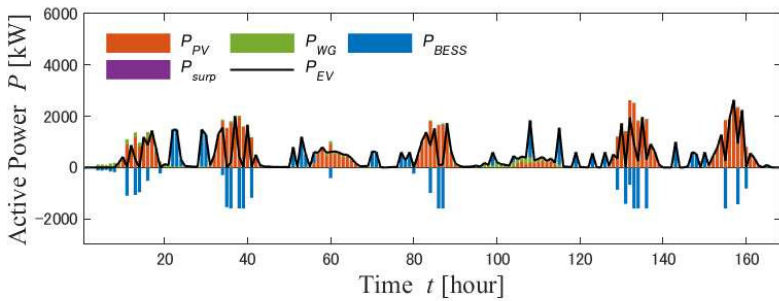
Figure 21. Generated power and load from April 1 to 7 (Case